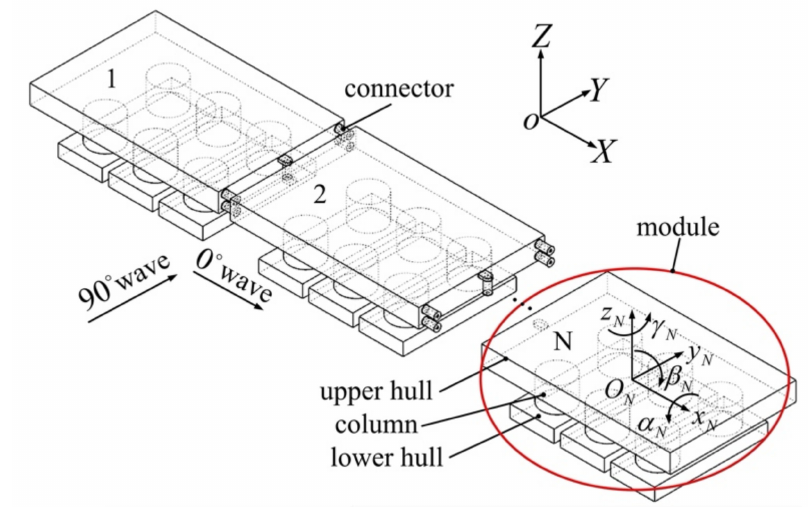
Figure 1. The schematic diagram of a multi-modular